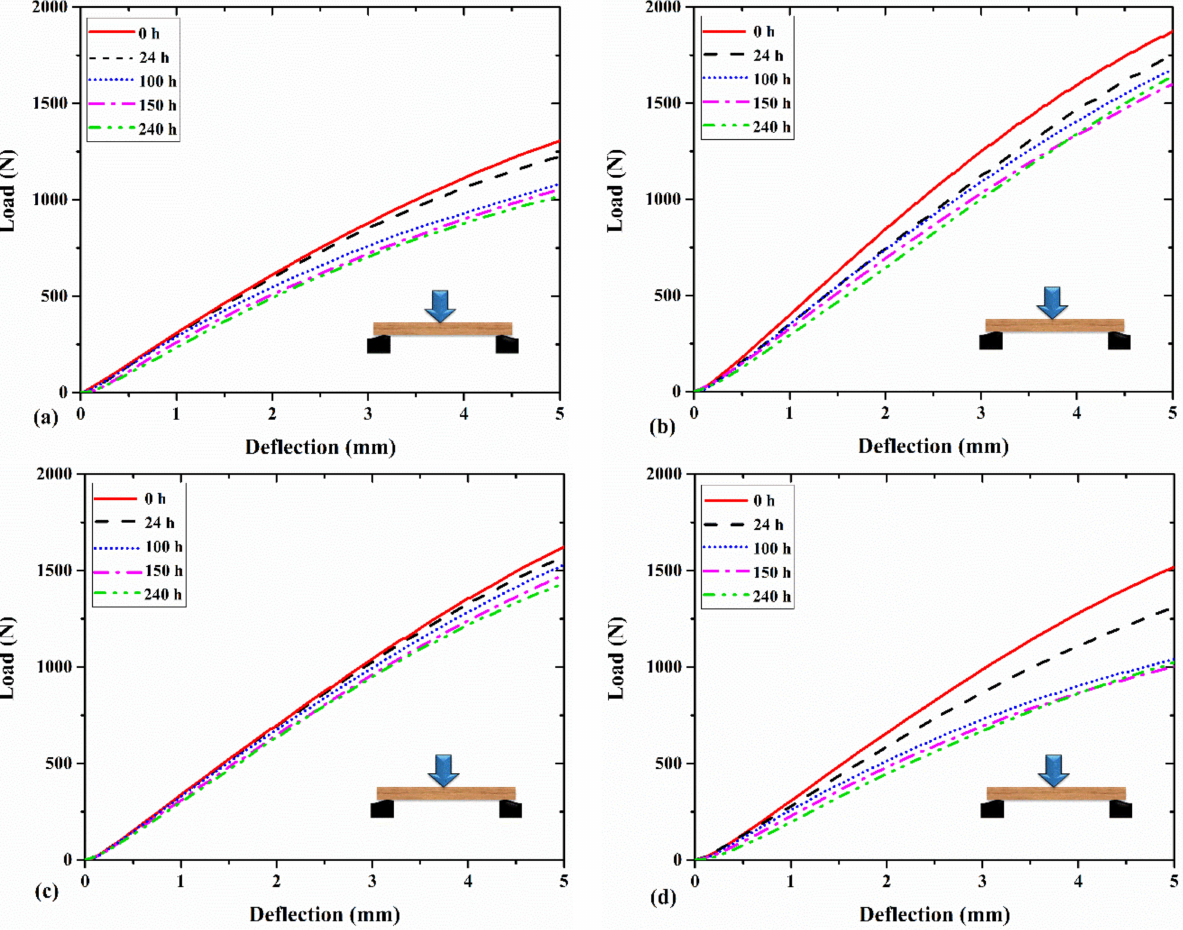
Figure 4. The load–deflection diagram for ( a ) fir, ( b ) alder, ( c ) oak, and ( d ) poplar wood samples exposed to different times of